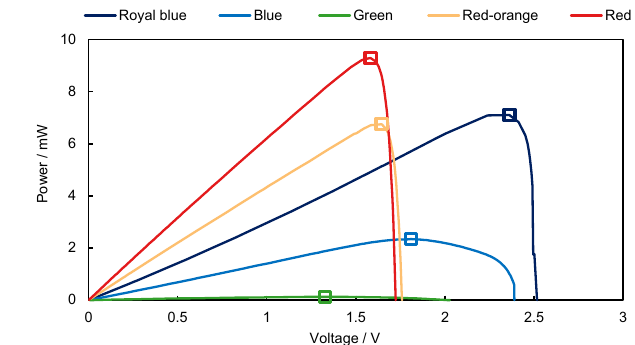
Figure 11. P − V characteristics of the measured LEDs, including the MPPs (marked as squares).